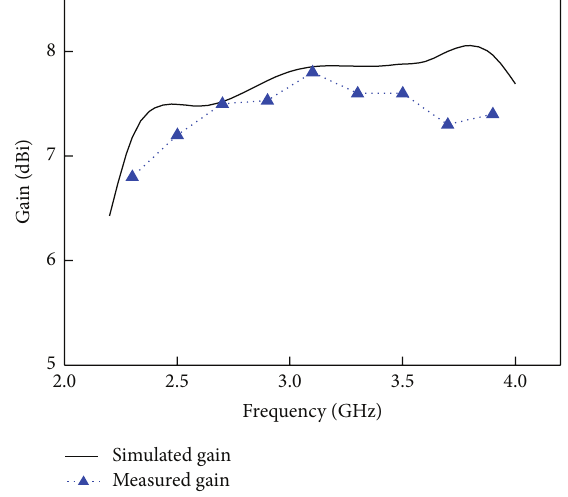
Figure 10: Measured and simulated gain of the proposed